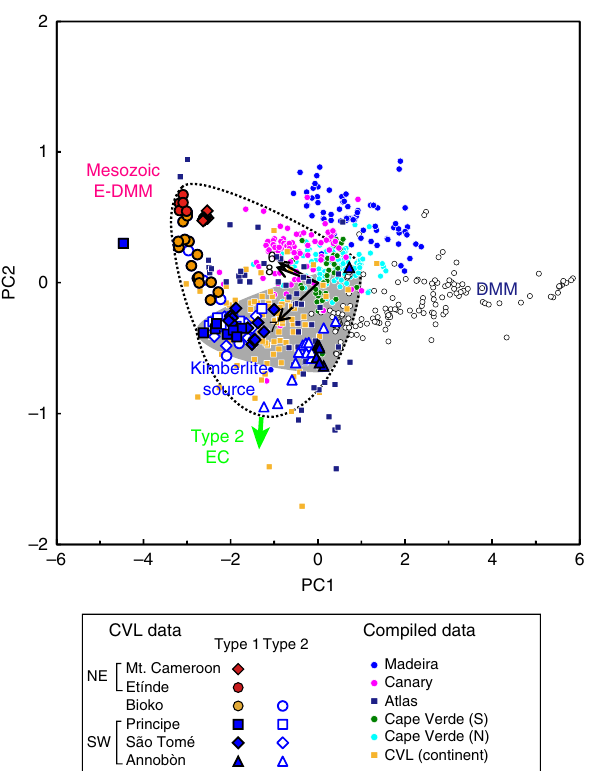
Fig. 7 Diagram of the principal component (PC) analysis of Pb isotope data. Plot of the fi rst and second PCs (PC1 and PC2) for three Pb isotopic ratios of WAPM-IB and Atlantic MORB samples ( N = 707). PC1 and PC2 accounted for 94.3 and 4.6 % of the total variability of the data, respectively. The regions shown with broken curves and grey areas are the ranges for the Cameroon volcanic line (CVL) and Type 1 SW lavas, respectively. DMM depleted mid-ocean ridge basalt source mantle, E- DMM enriched part of the DMM. Pb isotopic compositions of the compiled data from the GEOROC database were normalized to 206 Pb/ 204 Pb = 16.9424, 207 Pb/ 204 Pb = 15.5003, and 208 Pb/ 204 Pb = 36.7266 for SRM 981. All the Pb isotopic data applied to the calculations for the PC analysis were analysed by the double spike and Tl-doped methods, except for the Madeira and Atlas data (because all the available Pb data for Madeira and Atlas were analysed by conventional methods). The 2 SD error bars are smaller than the symbols for CVL data. The source data of the compiled values are provided in ref. 66